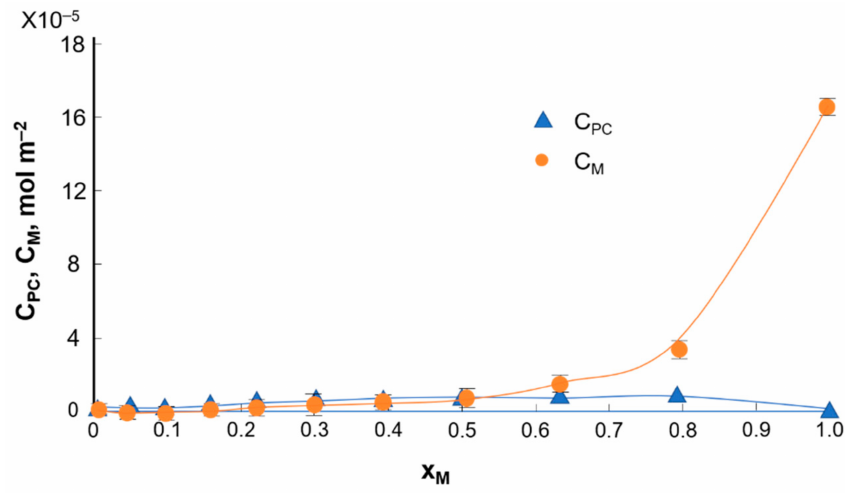
Figure 10. Dependence of the total surface concentration of PC (C PC) and M (C M ) vs. the mole fraction of M. Table 1. Calculated physicochemical parameters for examined complexes: